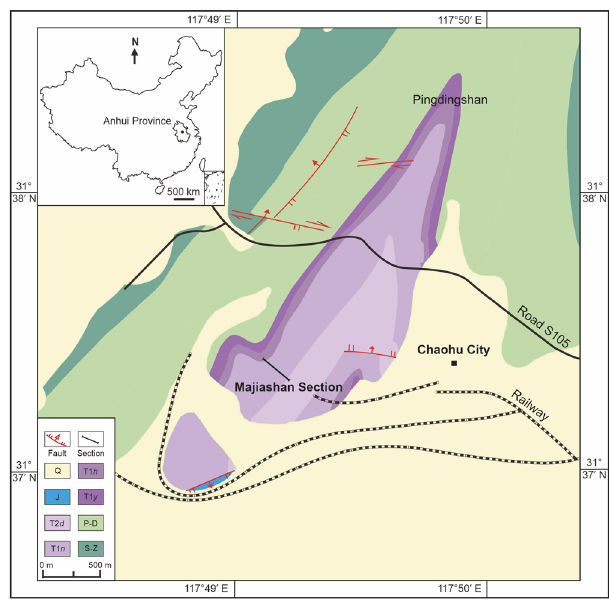
Fig. 1 Geological map (updated after ref. 50) showing the locality of